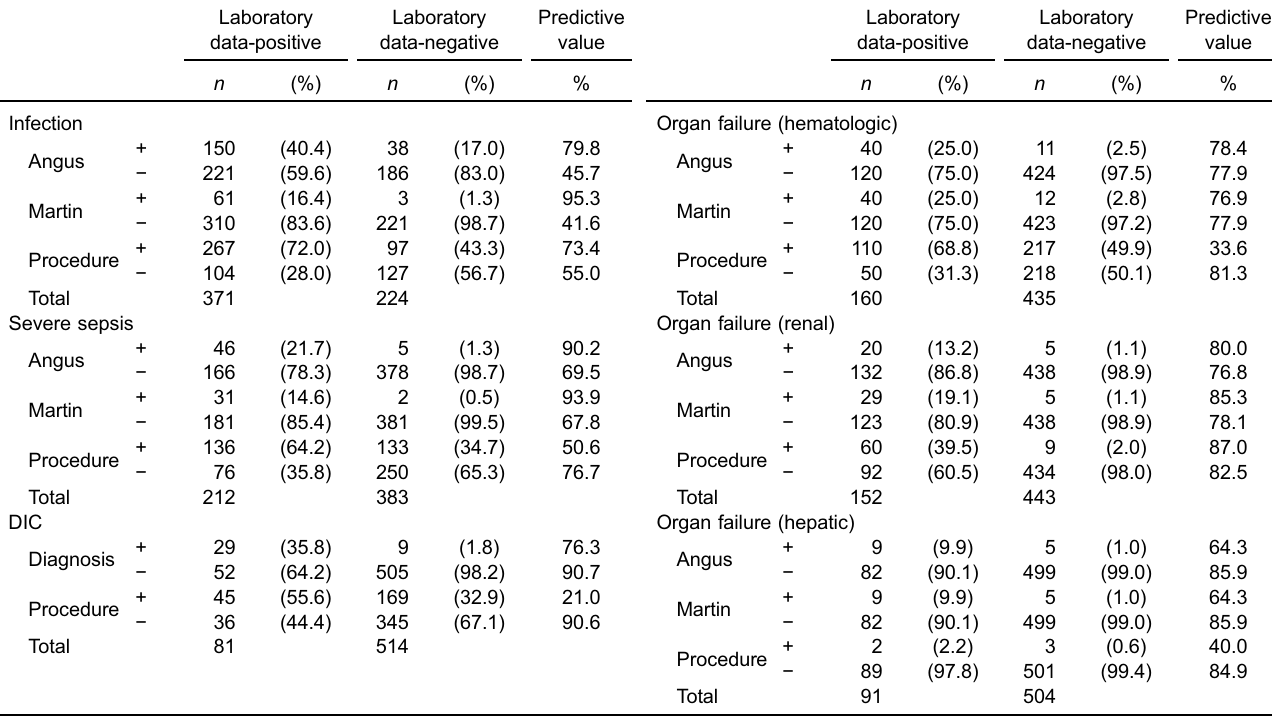
Table 4. Comparisons between diagnosis-, procedure-, and laboratory-data-based identi fi